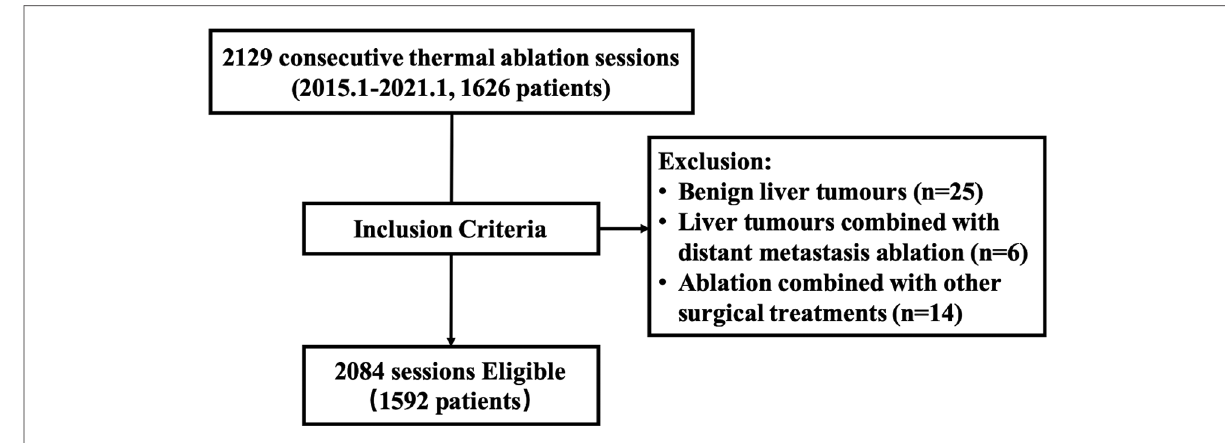
FIGURE 1 Flowchart of thermal ablation